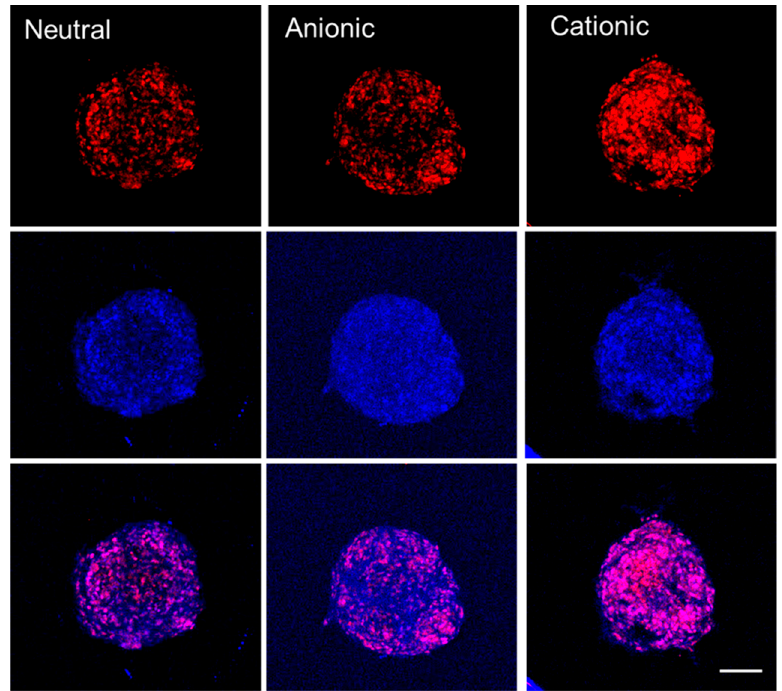
Figure 3. Cellular uptake of neutral, anionic, and cationic liposomes into spheroids. Red = doxorubicin. Blue = DAPI. Scale bar = 100 μ m.